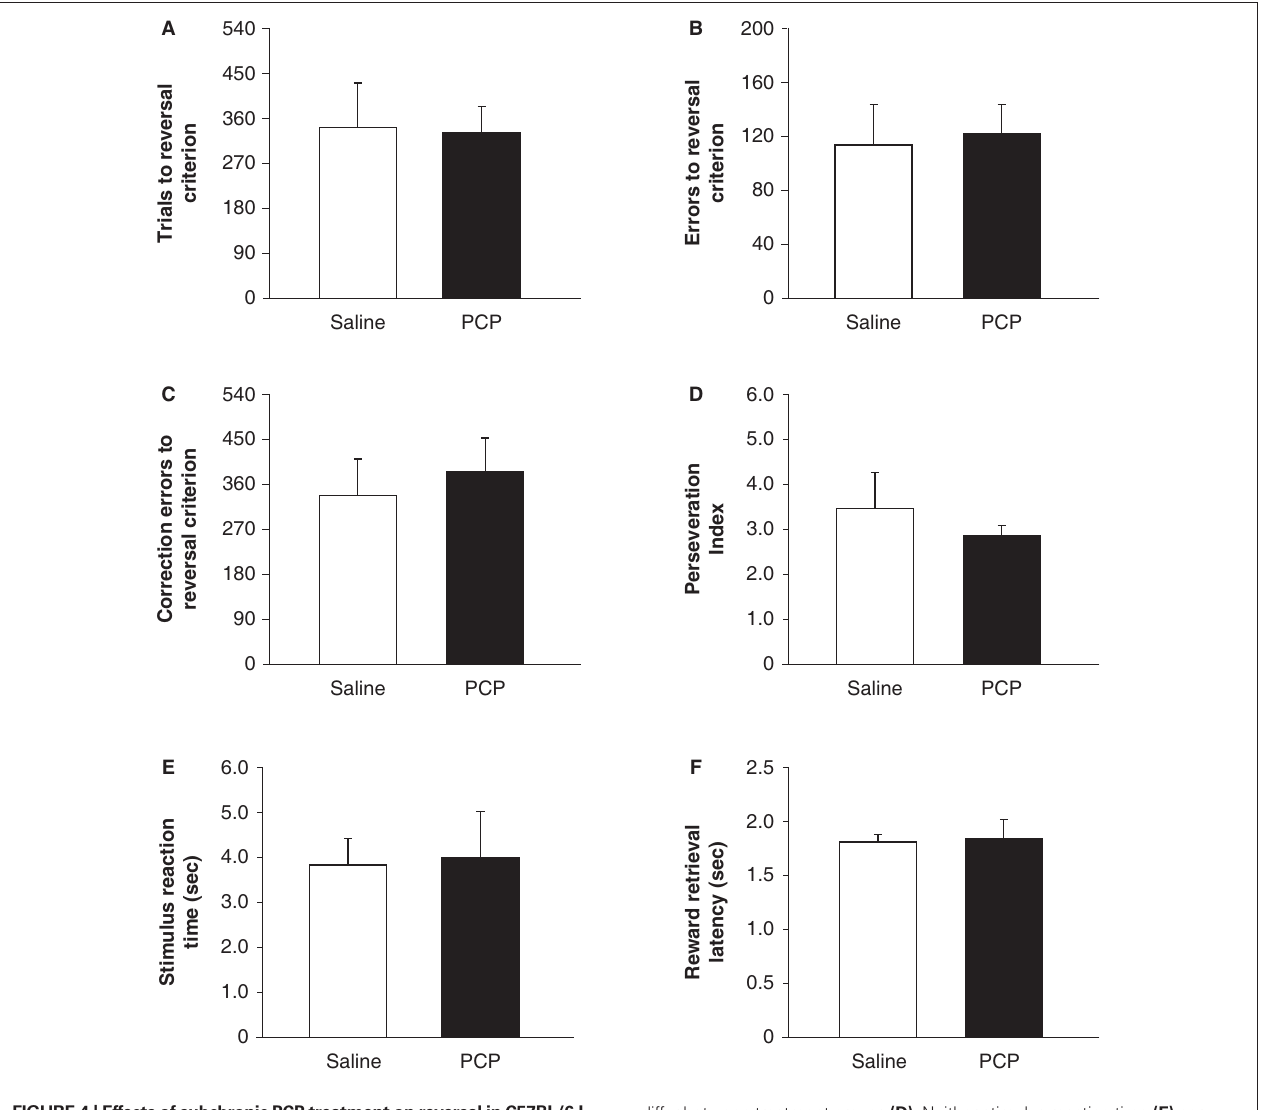
differ between treatment groups (D) . Neither stimulus reaction time (E) nor reward retrieval latency (F) differed between treatment groups. n = 7–8 per treatment. Data are mean ± SEM. # p < 0.05 vs. familiar/same treatment group, * p < 0.05 vs. saline.